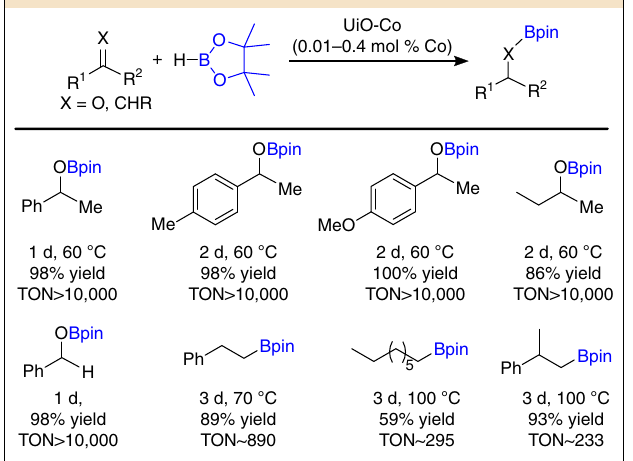
Table 4 | UiO-Co-catalysed hydroboration of aldehydes, ketones and alkenes.*